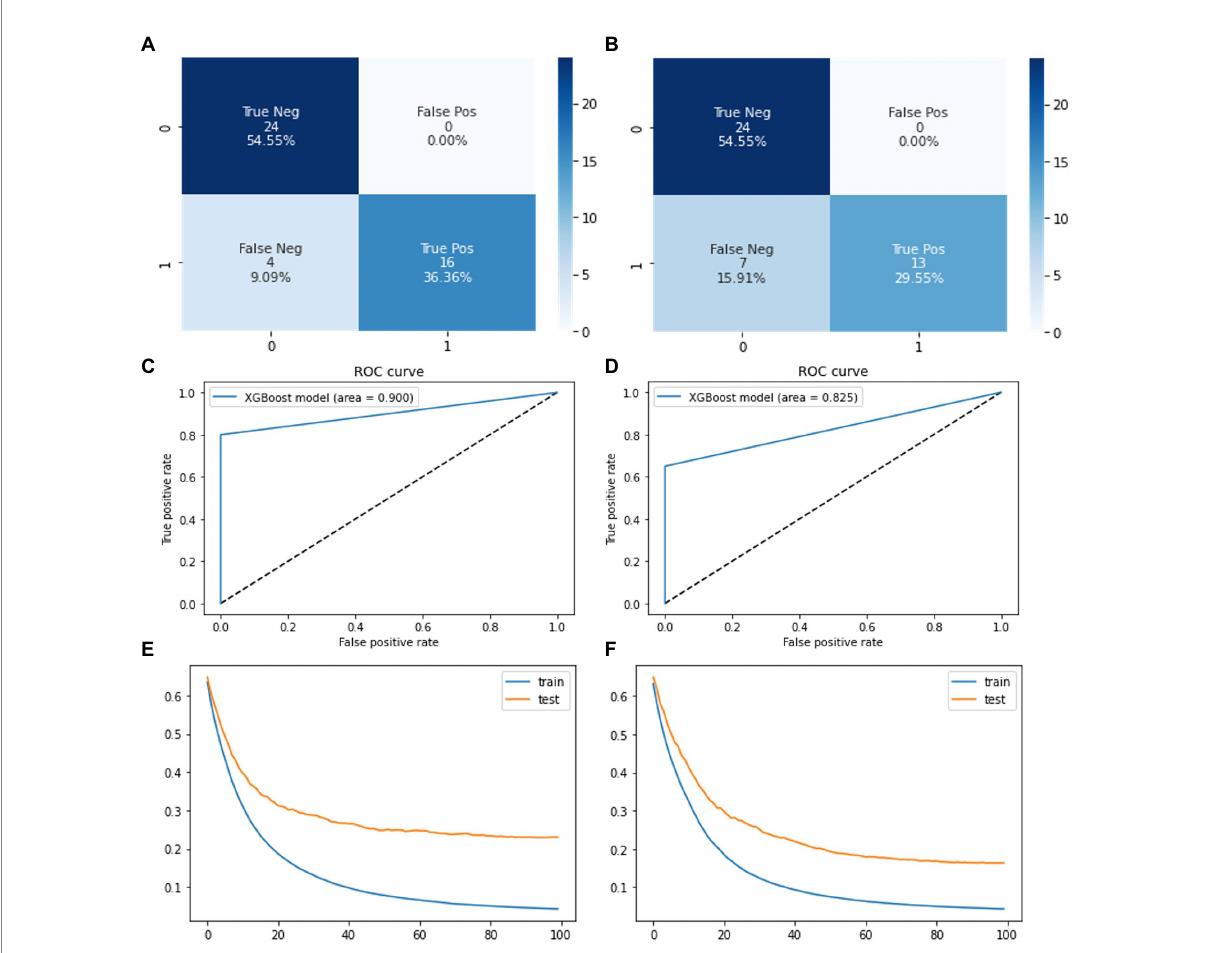
FIGURE 7 Confusion matrices showing the system performance of XGBoost on (A) VAE based synthetic data (B) GAN based synthetic data. ROC curve of XGBoost model on (C) VAE based synthetic data (D) GAN based synthetic data. Loss function for train and test set of XGBoost on (E) VAE based synthetic data (F) GAN based synthetic data.